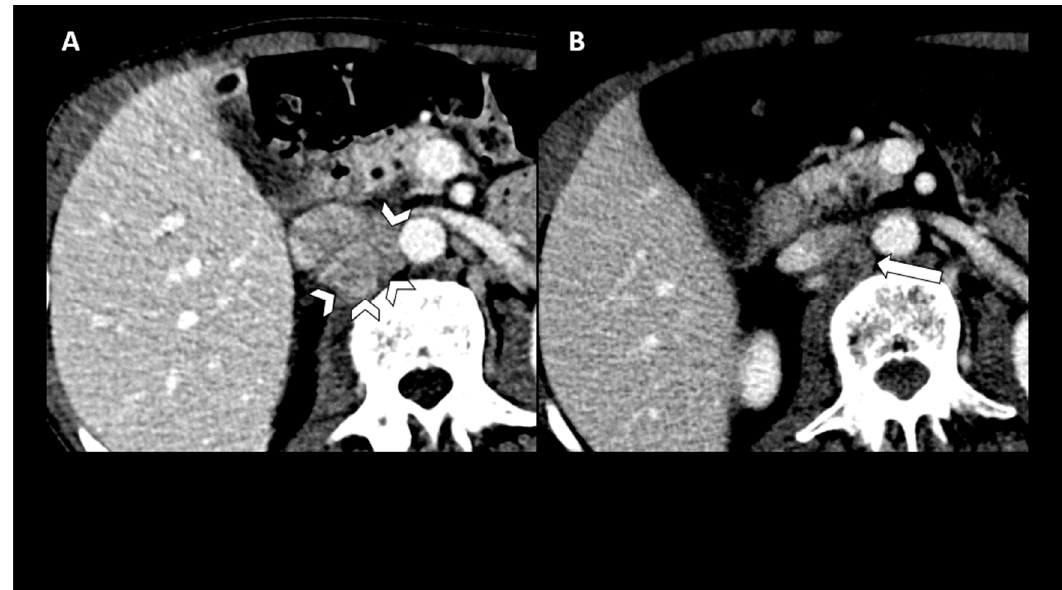
Figure 2. Computerized tomography ( CT) scan images from baseline ( A ) and post treatment ( B ). Time points represent significant decrease in size of necrotic right inguinal nodal mass infiltrating the muscle, originally 5.3 × 5.0 cm prior to radiation therapy (RT).